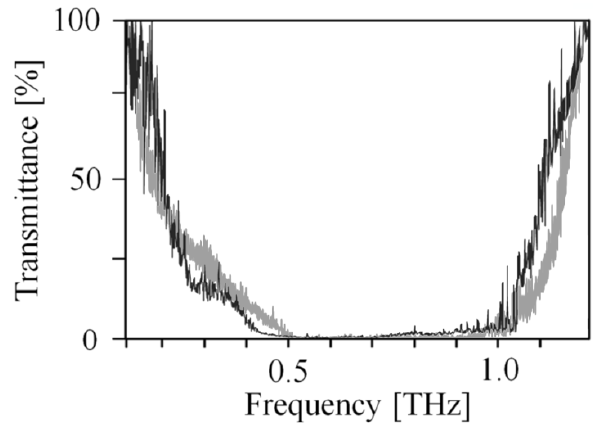
Figure 7. An electromagnetic band gap formation in a transmission spectrum of the terahertz wave through the magnetophotonic crystal with the diamond lattice structure. The black and gray lines show the measured and calculated results,